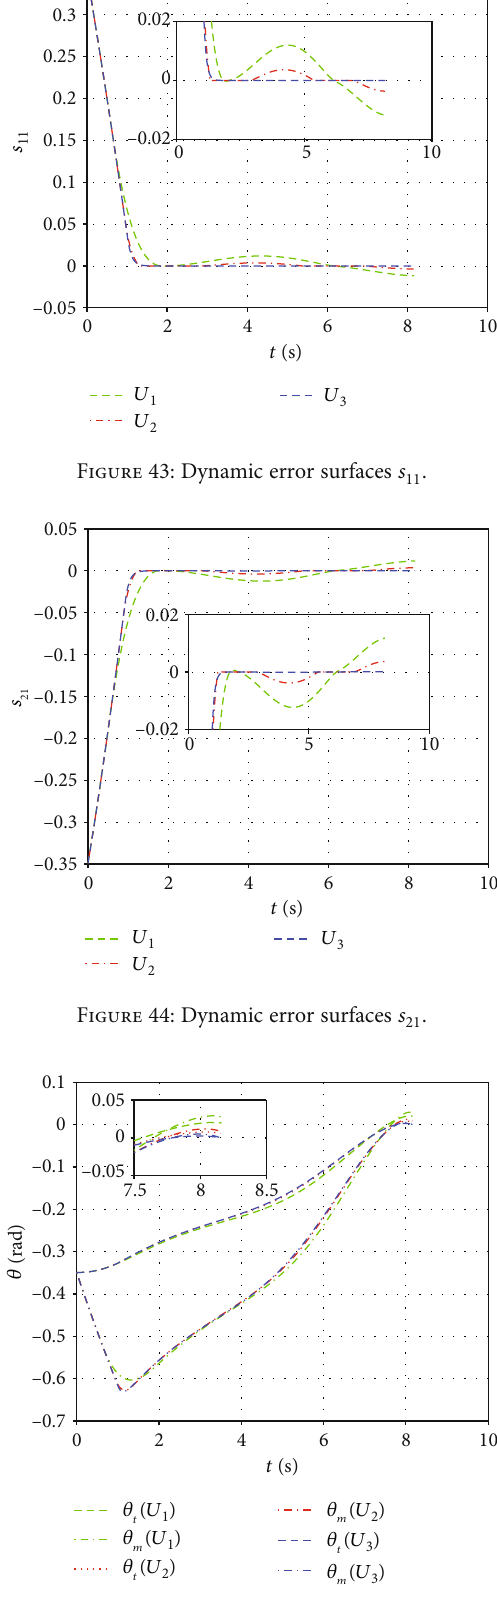
Figure 45: Direction angles θ